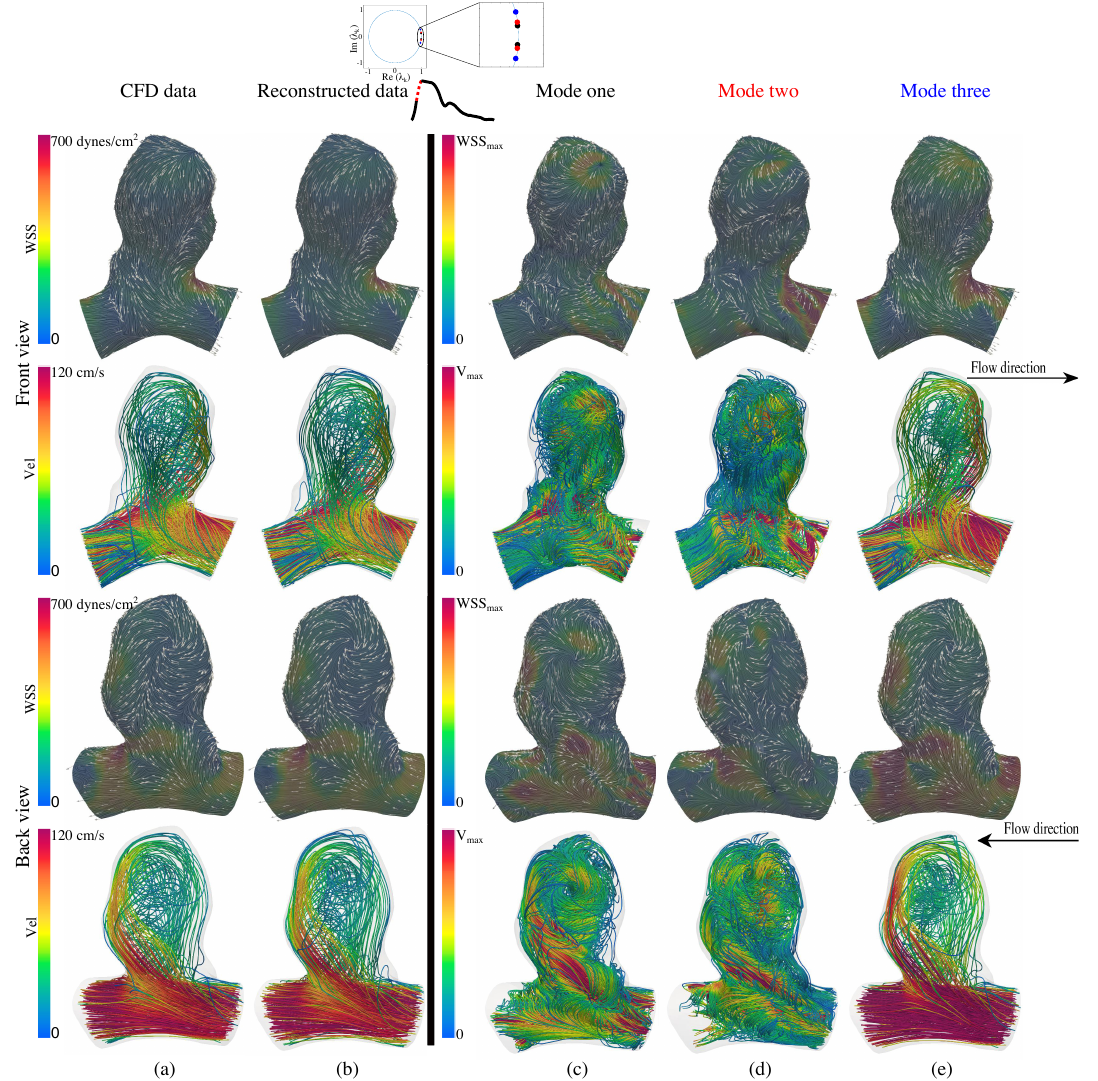
Figure 8. Velocity and WSS CFD data and the mDMDc modes are shown in the second stage of the cerebral aneurysm model. The stage is highlighted with a red dashed line in the flow waveform. The location of discrete eigenvalues in the unit circle corresponding to the selected mDMDc modes are shown. Velocity and WSS streamlines are shown and colored by their magnitude. WSS vectors are normalized and shown on top of the WSS streamlines to show the WSS vector direction. ( a ) CFD data (time = 0.01 s), ( b ) reconstructed data with 95% accuracy, ( c ) real part of the mDMDc mode corresponding to the eigenvalue λ = 0.99 ± 0.10 i , ( d ) real part of the mDMDc mode corresponding to the eigenvalue λ = 0.98 ± 0.14 i , ( e ) real part of the mDMDc mode corresponding to the eigenvalue λ = 0.97 ± 0.26 i